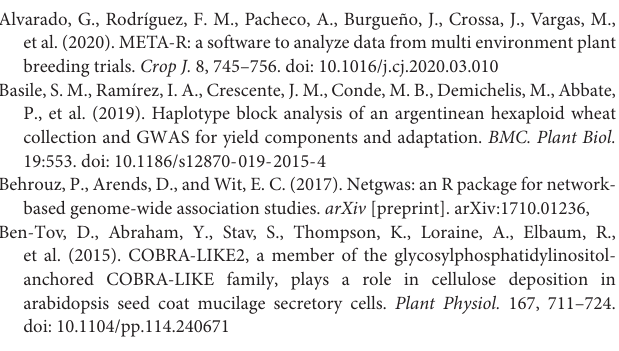
Supplementary Figure 2 | Linear regression between number of favourable alleles and BLUP values observed for selected traits. Supplementary Figure 3 | Predicted 3D structures of proteins translated by candidate